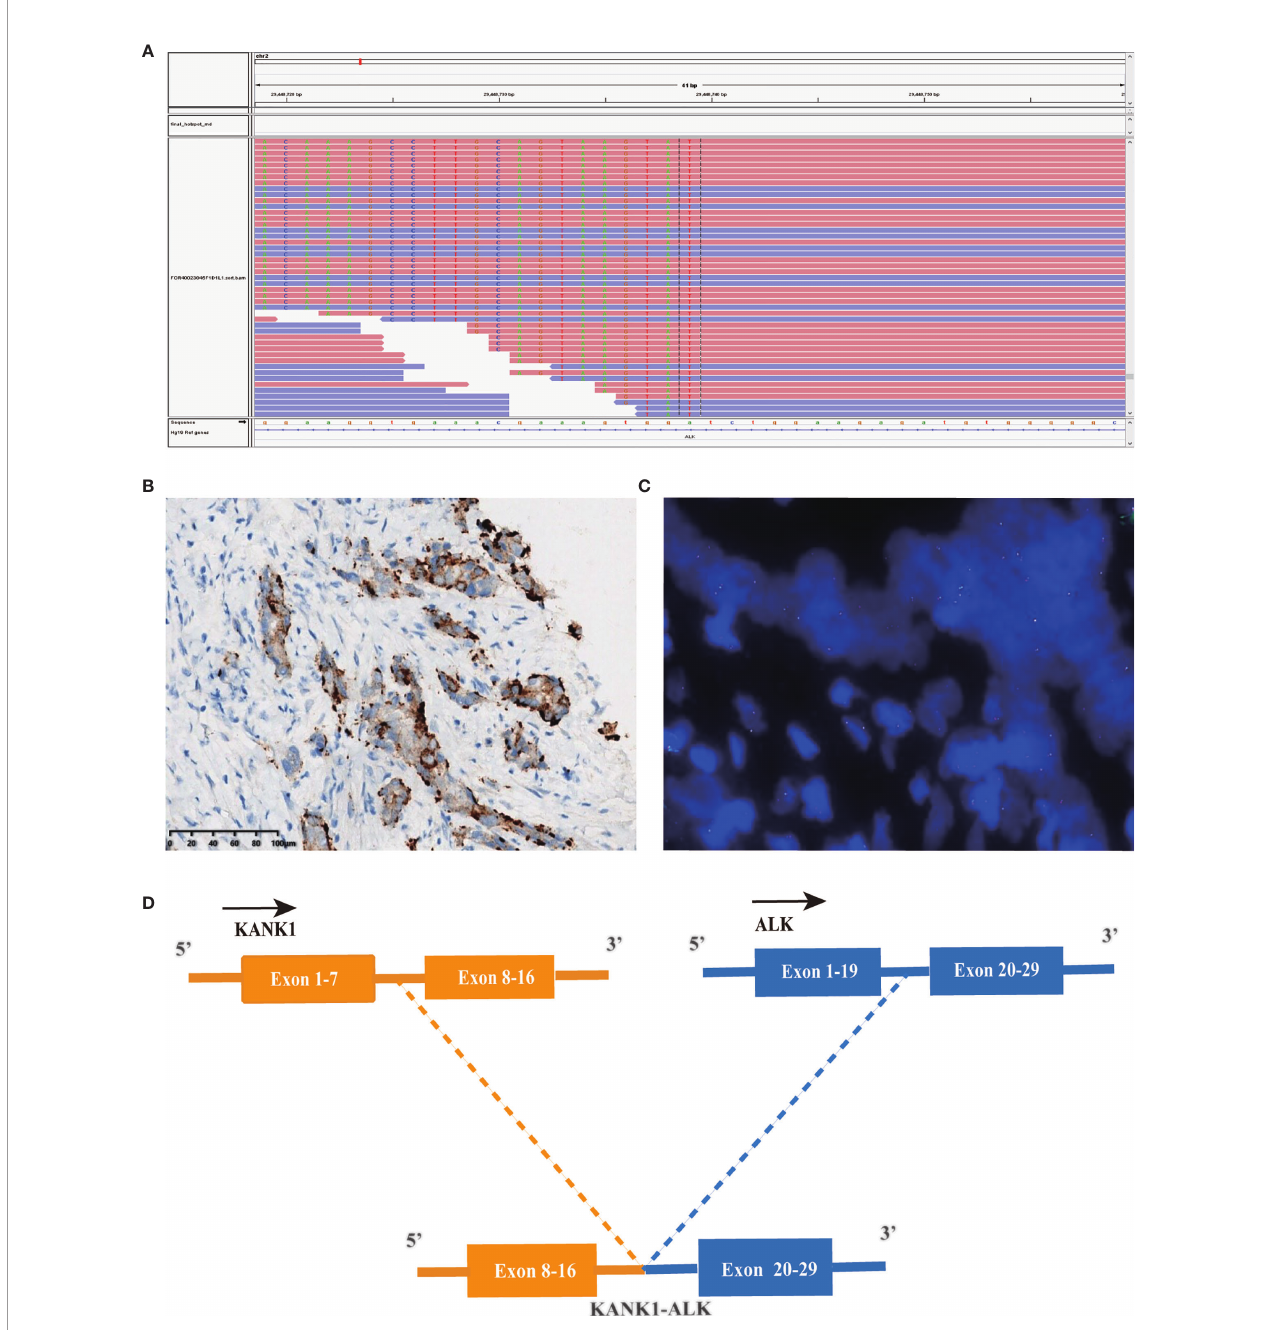
FIGURE 2 | A novel KANK1-ALK fusion was discovered in a PDCA patient. (A) Sequencing reads of ALK is shown by the Integrative Genomics Viewer. (B) Immunohistochemistry staining indicated expression of ALK, the specimen was stained by IHC with the anti-ALK (D5F3) primary antibody. (C) A split signal was observed with a frequency of 18% in the fl uorescence in situ hybridization image using ZytoLight ALK Break Apart FISH Probe. (D) Illustration of KANK1-ALK